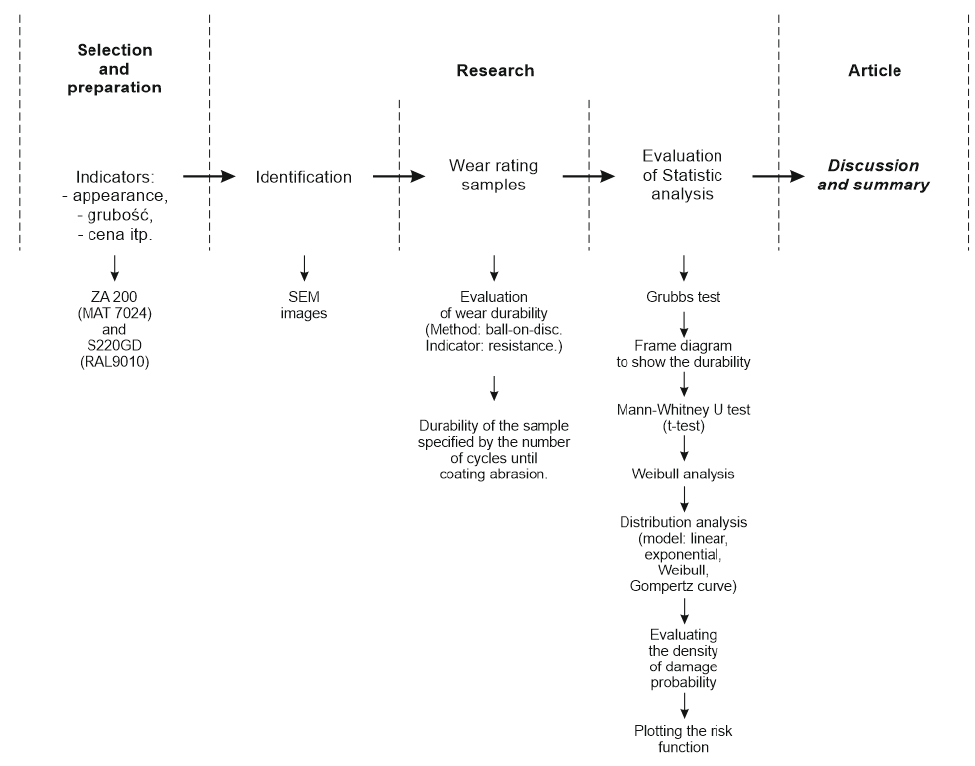
Figure 1. Schematic of the management of the research.